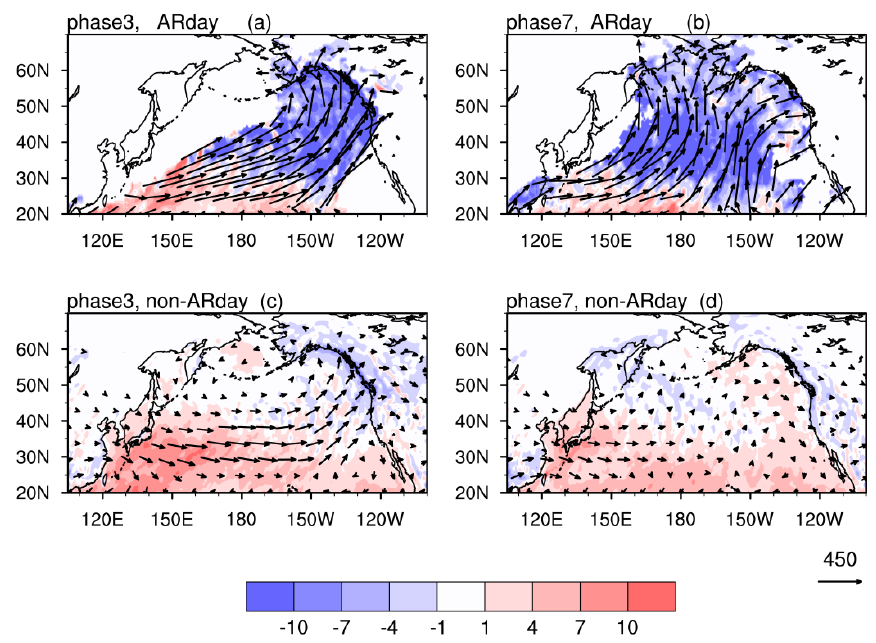
Figure 6. Composite fields of IVT (vector; kg m − 1 s − 1 ) and ∇· IVT (shaded areas; kg m − 2 d − 1 ) in phases three ( a , c ) and seven ( b , d ) for group AR days ( a , b ) and non-AR days ( c , d ). Only the fields with AR frequency exceeding 10% are shown in ( a ) and ( b ).